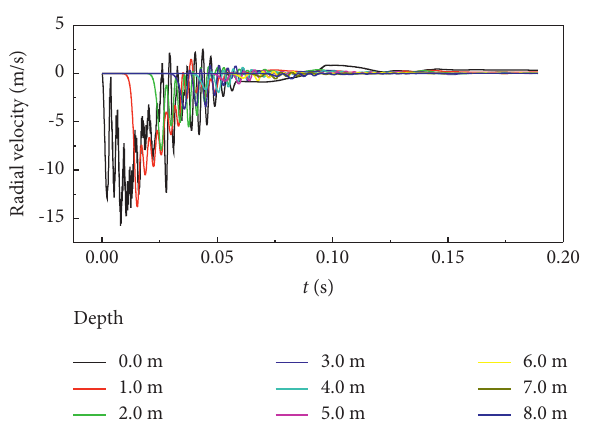
Figure 15: Vertical velocity of soil particles directly below the rammer.